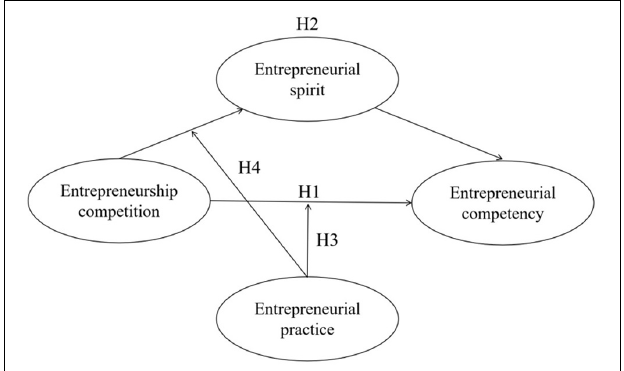
FIGURE 1 | Research